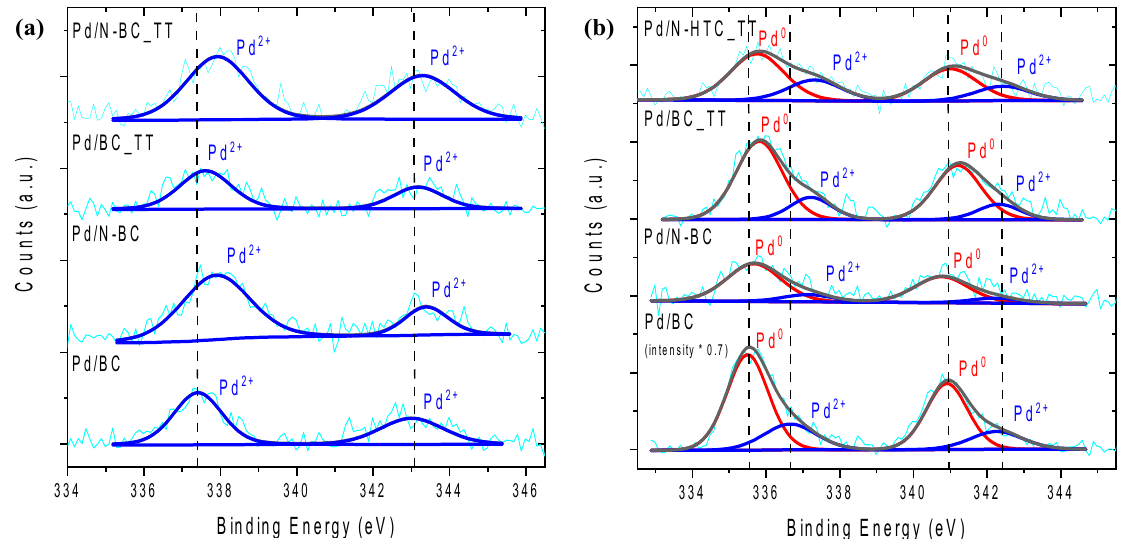
Figure 7. XPS Pd 3d spectra of ( a ) fresh catalysts and ( b ) after six cycles.